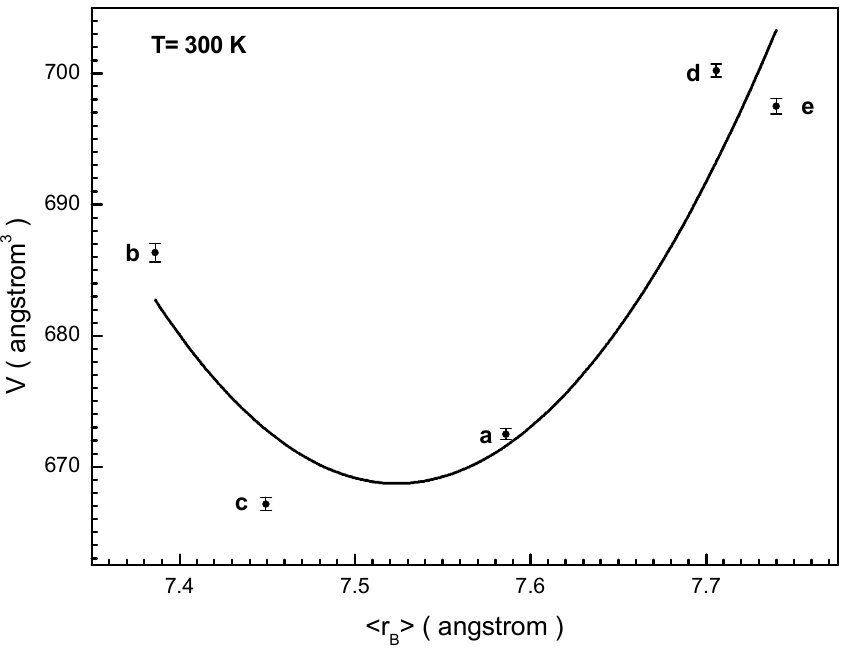
Dependence unit cell volume vs. (cid:104) r B (cid:105) average radius of B sub-lattice at Figure 2. Dependence unit cell volume vs. 〈 r B 〉 average radius of B sub-lattice at 300 K for the ( a ) 300 K for the (a) BaFe 5.84 Ga 6.19 O 19 , (b) BaFe 6.26 Al 2.27 Cr 3.47 O 19 , (c) BaFe 6.11 Al 1.56 Gr 2.17 Ga 2.16 O 19 , BaFe 5.84 Ga 6.19 O 19 , BaFe 6.19 Al 1.25 Cr 1.57 Ga 1.74 In 1.26 O 19 , (e) initial BaFe 12 O 19 compound. The line is the second order polyno- (d) BaFe 6.19 Al 1.25 Cr 1.57 Ga 1.74 In 1.26 O 19 , (e) initial BaFe 12 O 19 compound. The line is the second order mial interpolation of experimental data. polynomial interpolation of experimental